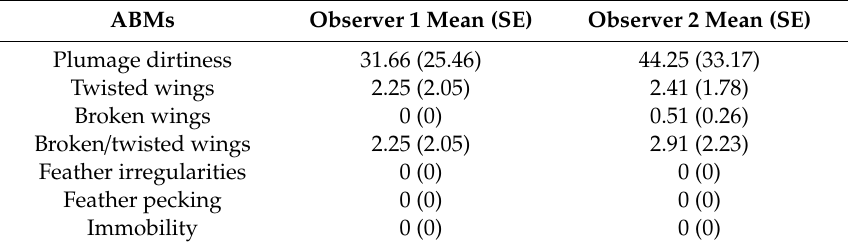
Table 2. Mean ( ± SE) prevalence of geese (number of observations, n = 100) within each ABMs category assessed during animal inspection for Obs-1 and Obs-2 in all the inspected farms ( n =